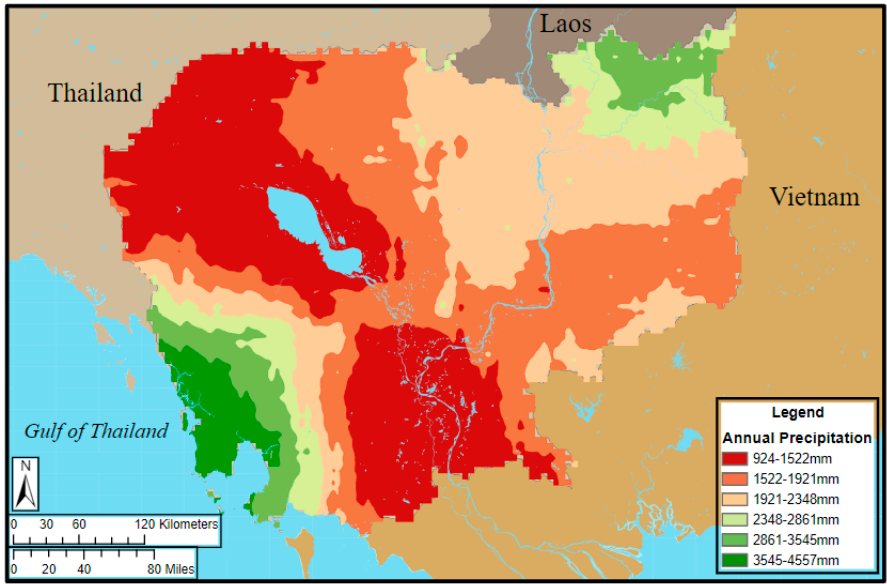
Figure 3. Annual precipitation map of Cambodia. Adapted from UCSB’s [32] CHIRPS database.